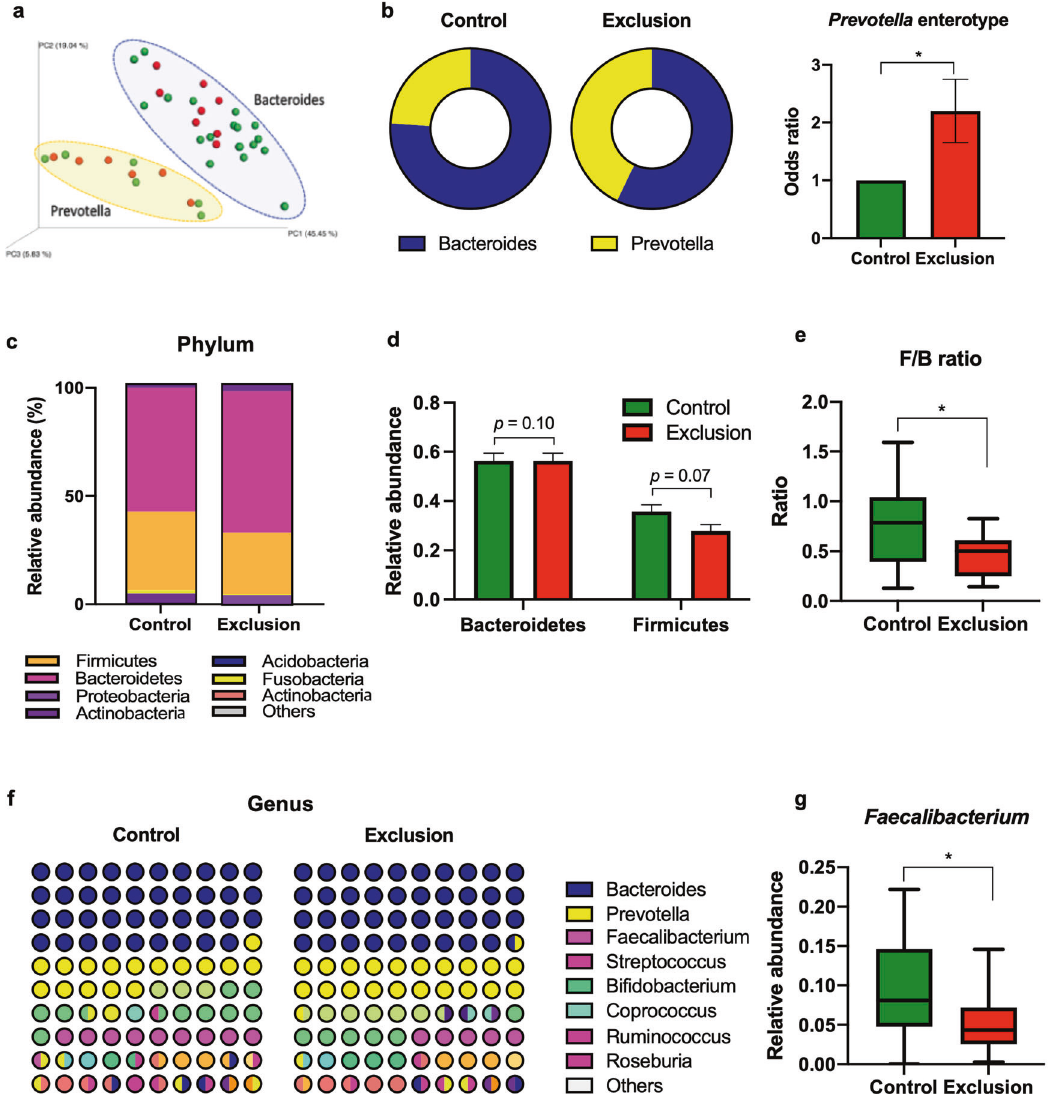
Fig. 1 Gut microbiota pro fi ling in individuals with and without social exclusion experience. a Principal Coordinate Analysis (PCA) plot of microbiome samples from the control and exclusion groups. b Pie charts showing the percentage of Bacteroides or Prevotella spp. in the samples from the control and exclusion groups. The bar graph shows odds ratios and the 95% con fi dence interval for the probability of having Prevotella -enriched enterotype in the exclusion group compared to the control group. c Relative abundance (%) of the phyla in the two groups of participants shown as a stacked bar graph. d Relative abundance of the two most abundant phyla Bacteroidetes and Firmicutes shown as a bar graph. e The ratio of Firmicutes to Bacteroidetes shown as a box-and-whisker plot. f Relative abundance of bacteria at the genus level in the control and exclusion groups shown as a dot plot matrix. g Relative abundance of the genus Faecalibacterium shown as a box-and-whisker plot. The lowest and highest points in a box-and-whisker plot correspond to the minimum and maximum of the data set, respectively, and the horizontal line in the middle indicates the mean value. * P < 0.05 according to t